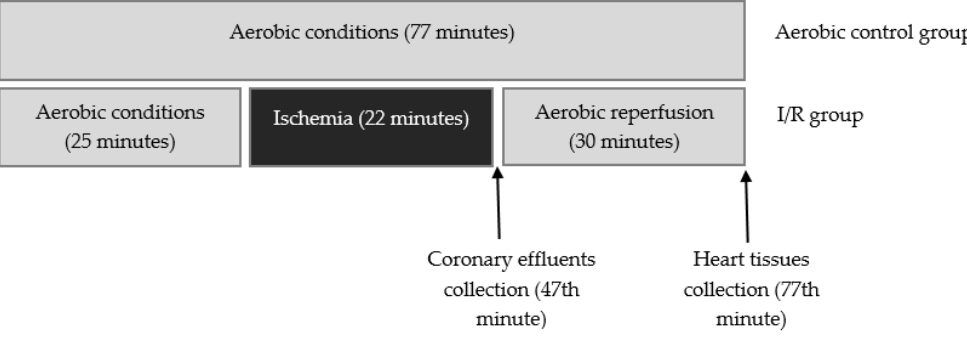
/ R group and aerobic